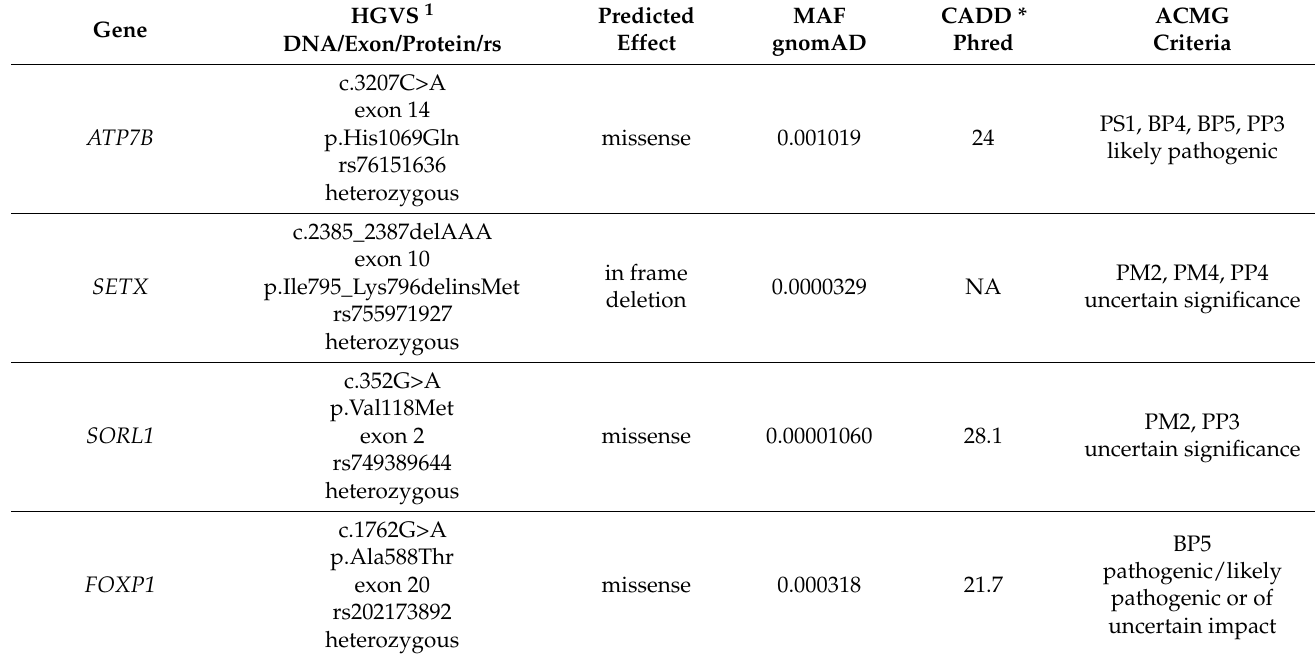
Table 2. The rare variants of.the highest impact on the disease phenotype according to bioinformatic